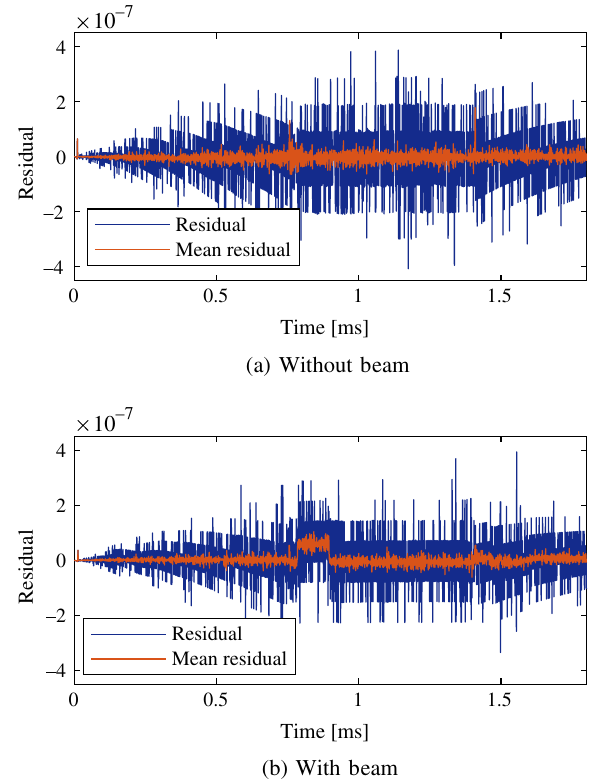
FIG. 3. Nominal residuals without and with the beam. In blue, the residuals of one pulse are shown, in red, the residuals are averaged over 50 pulses. The presence of the beam is clearly visible as a step up corresponding to the duration of the bunch train, between 0.8 and 0.9 ms. The spikes around 0.8 and 1.4 ms mostly visible on the residual trace without a beam are actually due to imperfections in the time alignment between the different rf waveforms and are not beam dependant.